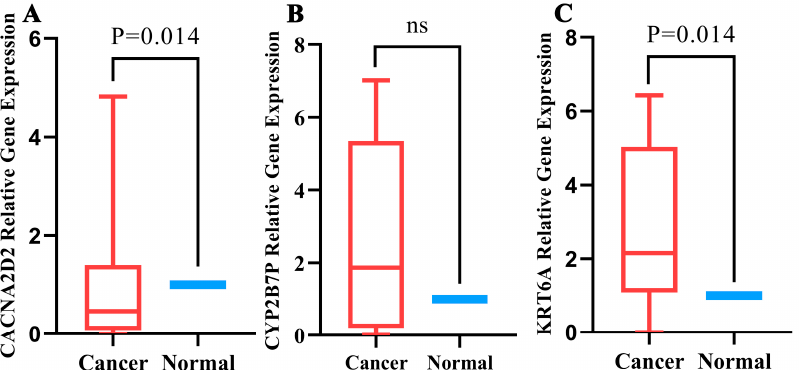
Figure 10. The relative expression levels of the 3 genes in normal and lung adenocarcinoma (LUAD) tissues using qRT-PCR. The expression levels of CACNA2D2 were downregulated in LUAD tissues ( A ) There was a trend of upregulation of CYP2B7P in LUAD tissues ( B ) and that KRT6A was upregulated in LUAD tissues ( C ).